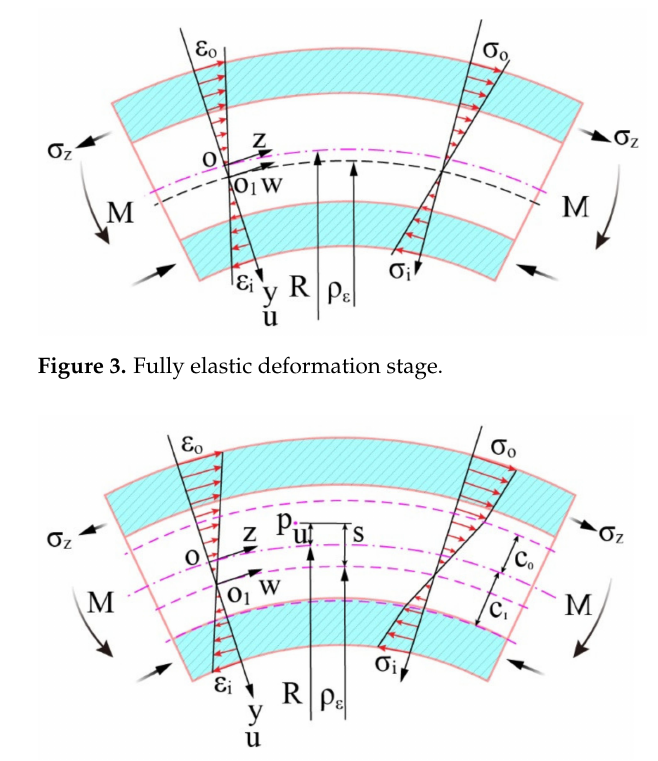
Figure 4. Elastic–plastic deformation